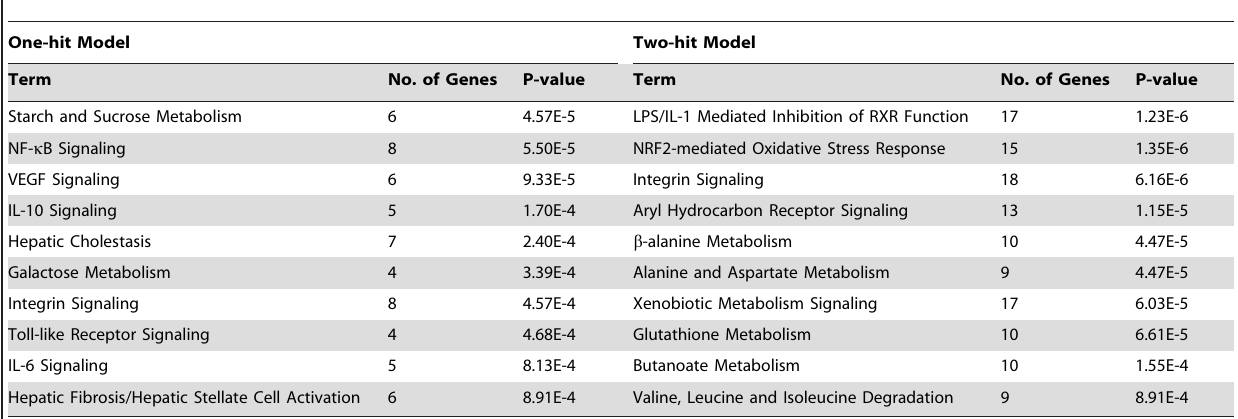
Table 6. Top 10 canonical pathways enriched in one-hit and two-hit models of VILI.